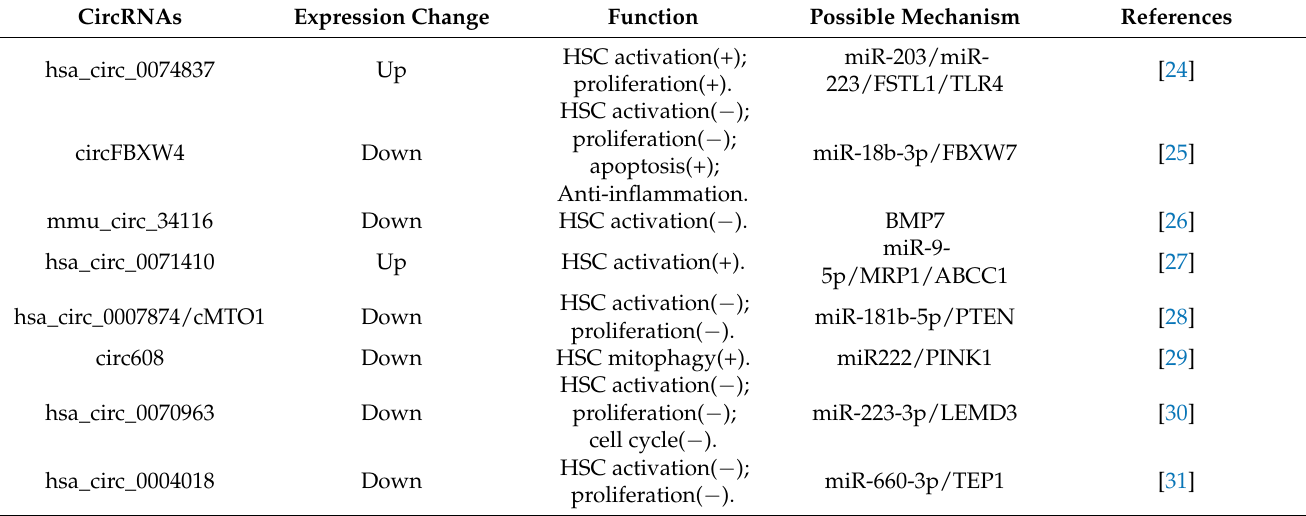
Table 1. Expression and Function of dysfunctional circRNA in